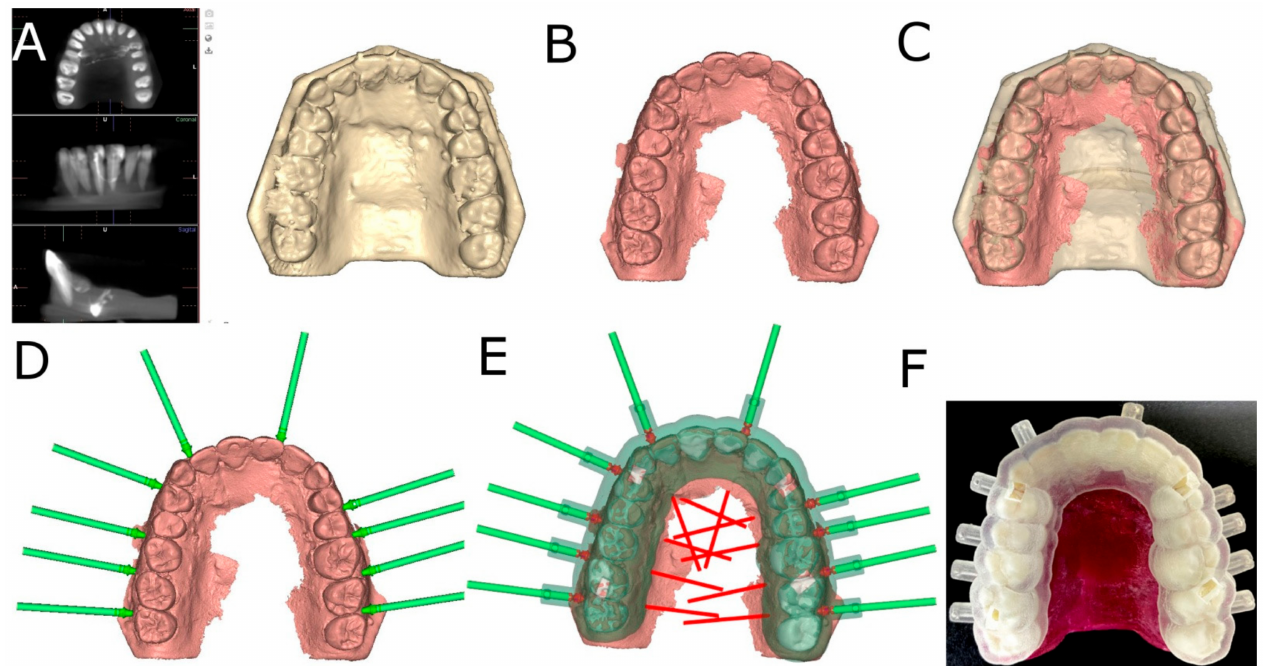
Figure 1. ( A ) DICOM files from the CBCT scan, ( B ) STL digital file from the digital impression, ( C ) alignment procedure between STL and CBCT scan digital files, ( D ) orthodontic micro-screws planning position, ( E ) surgical template design and ( F ) manufacturing.